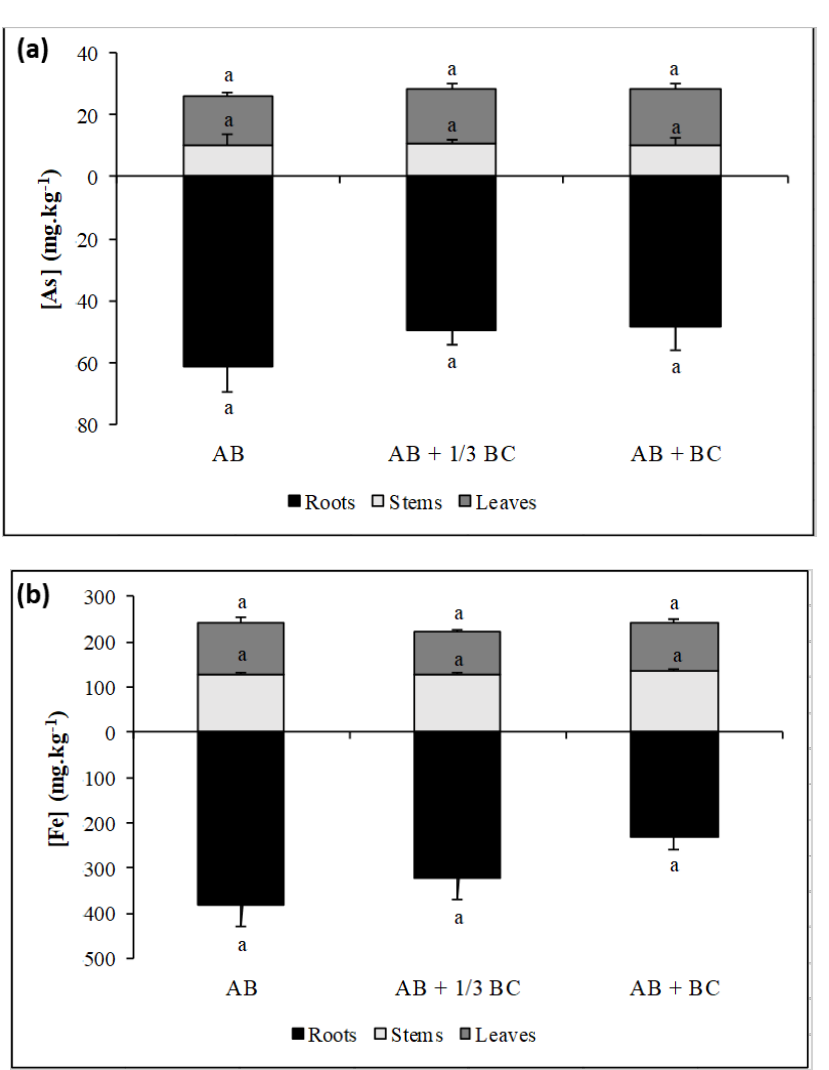
Figure 5. ( a ) Arsenic ([As] = mg · kg − 1 ) and ( b ) iron ([Fe] = mg · kg − 1 ) concentrations in the different organs (gray box, leaves; light gray box, stems; black box, roots) of the Alnus planted in March 2019 (T0) and sampled in October 2020 (T19), grown on Abbaretz (AB) technosol non amended or amended with 2% biochar added to the top 33 cm of the tube (AB + 1/3 BC) or all of the tube (AB + BC). Plant organs were sampled in October 2020. The treatment effect represented by the letters ( p ≤ 0.05) is mean of seven values (± SE).